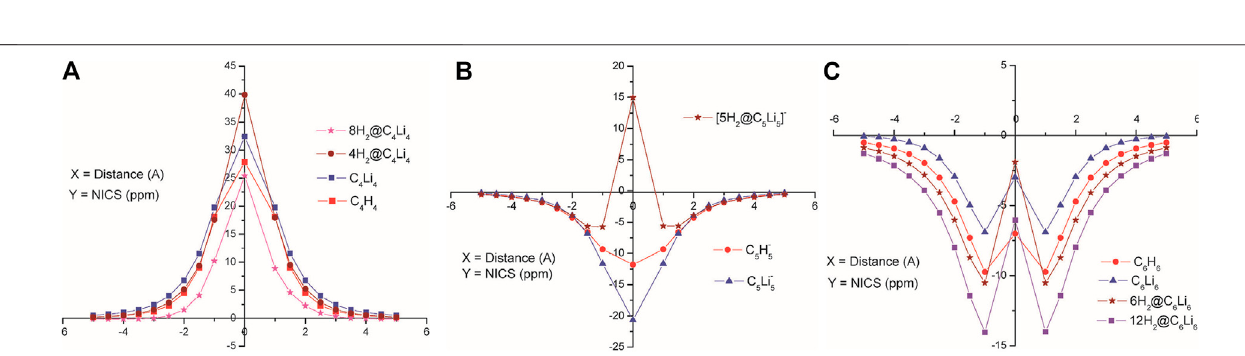
FIGURE5| NICS-scan plotsforthe parent moieties, their Lianalogues, and hydrogen loaded systemsof (A) C 4 Li 4 , (B) C 5 H 5 − ,and (C) C 6 H 6 species (Reproduced from Giri et al., 2011c with permission from the PCCP Owner Societies).